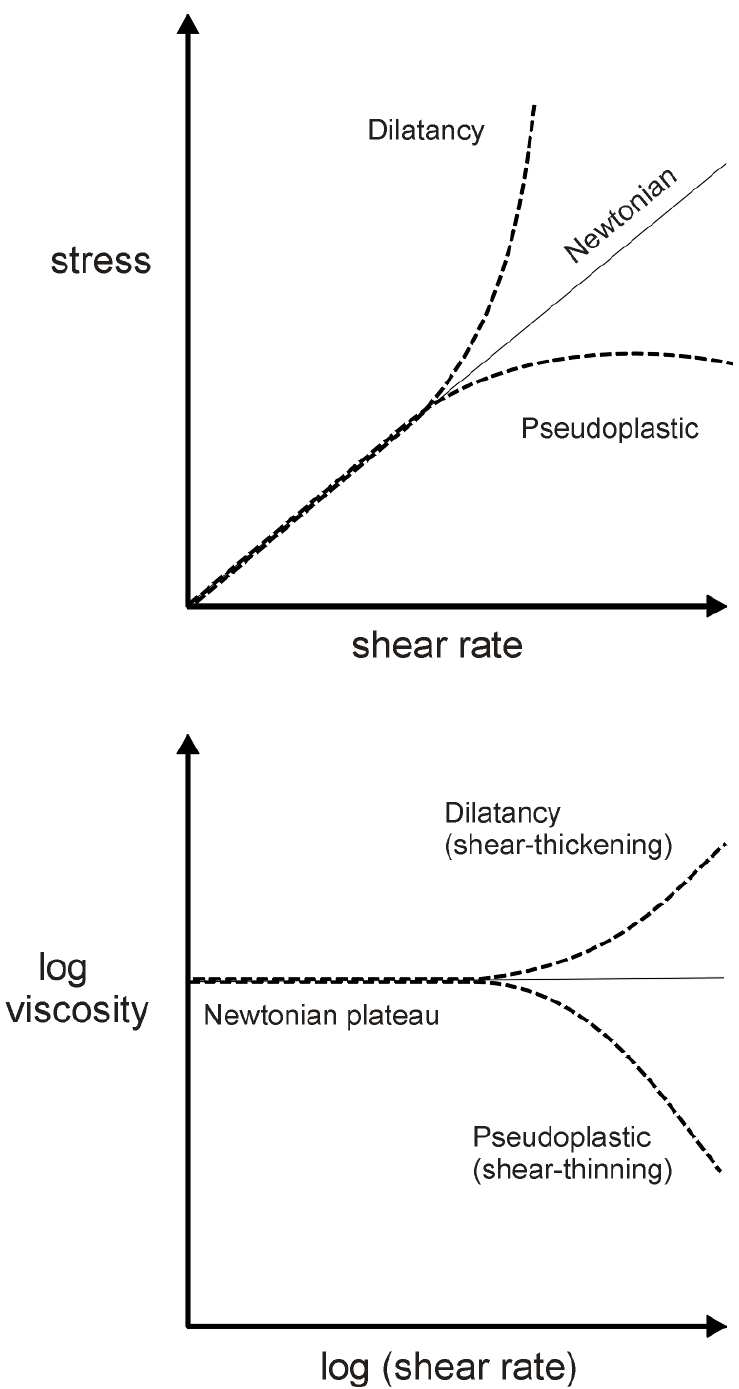
FIGURE 2 . Flow curves for different classes of fluids. procedure. Fig. 3 illustrates the principle — a sinusoidal oscillation of maximum strain γ and oscillatory frequency ω is applied to a sample using cone-and-plate plate geometry. If the material is perfectly elastic then the resultant stress wave is exactly in phase with the strain wave. By contrast, since the strain rate is maximum when the strain is zero and vice versa, for purely viscous systems, the resultant stress wave will be exactly 90 0 out-of-phase with the imposed